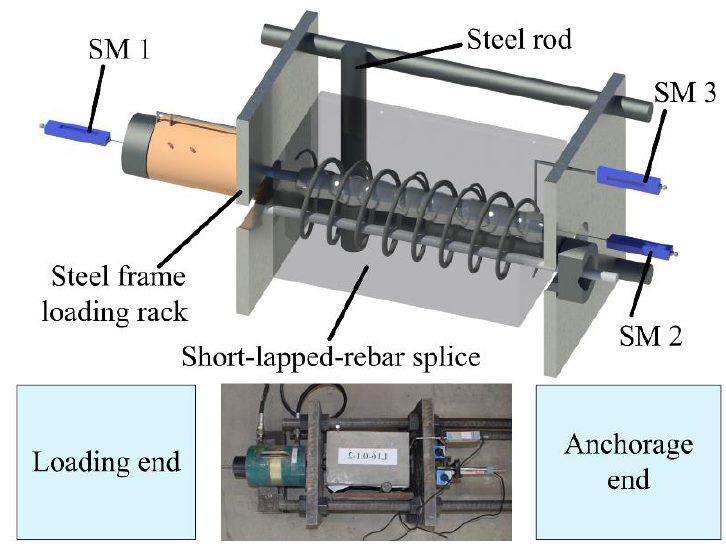
Figure 5. Testing schematic.